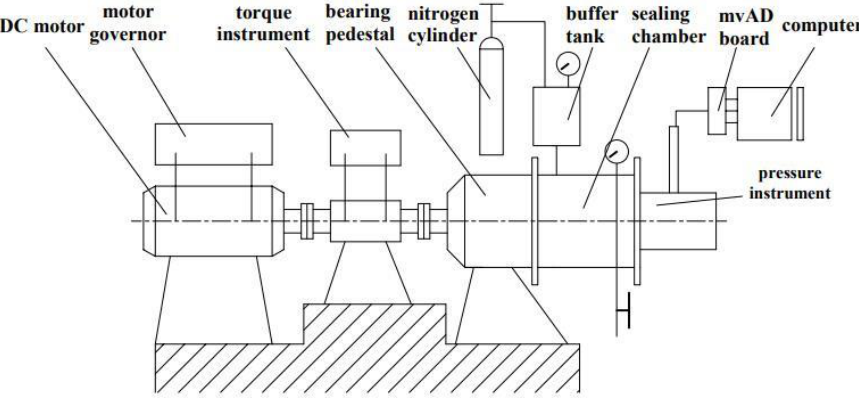
Figure 9. Experimental device from the literature [33].